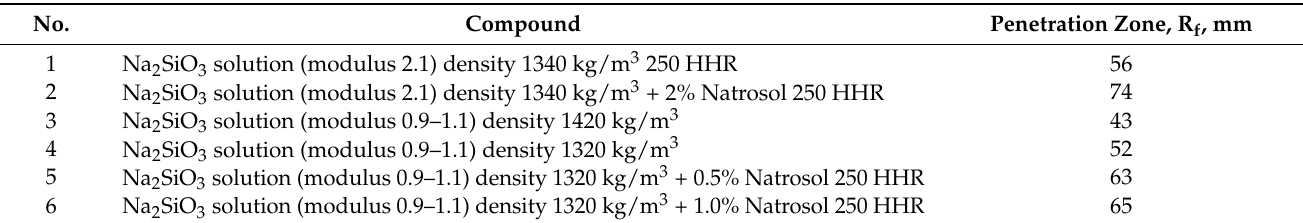
Table 5. The dependence of the filtrate penetration zone depending on the composition.